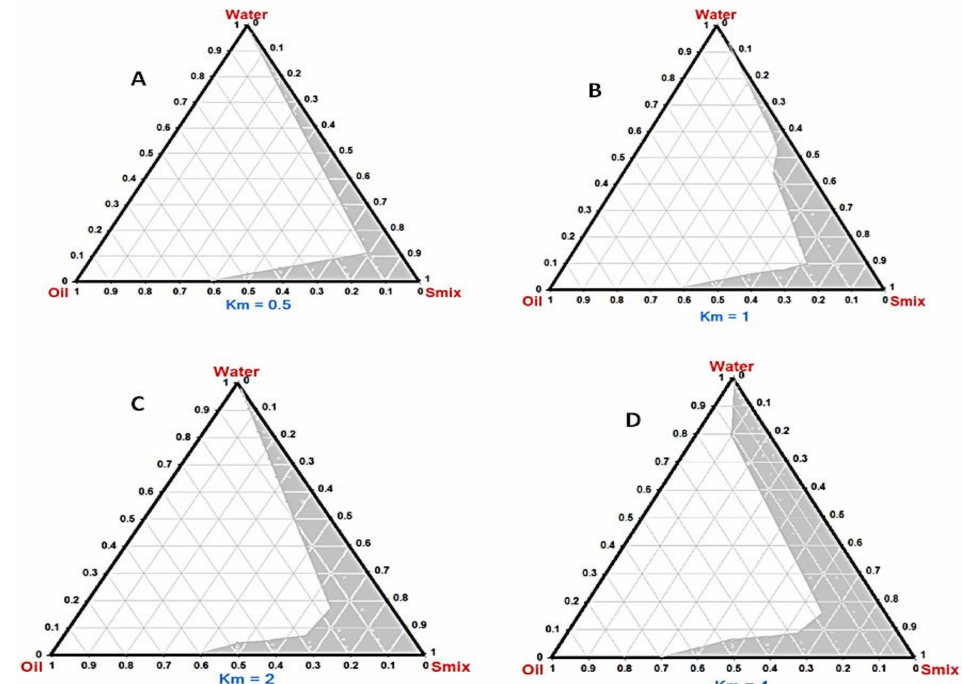
Figure 3. Ternary phase diagrams depicting the nanoemulsion region (NE, shadow areas). Km: Surfac- tant/cosurfactant mass ratio. ( A ) Km = 0.5:1, ( B ) Km = 1:1, ( C ) Km = 2:1, ( D ) Km =